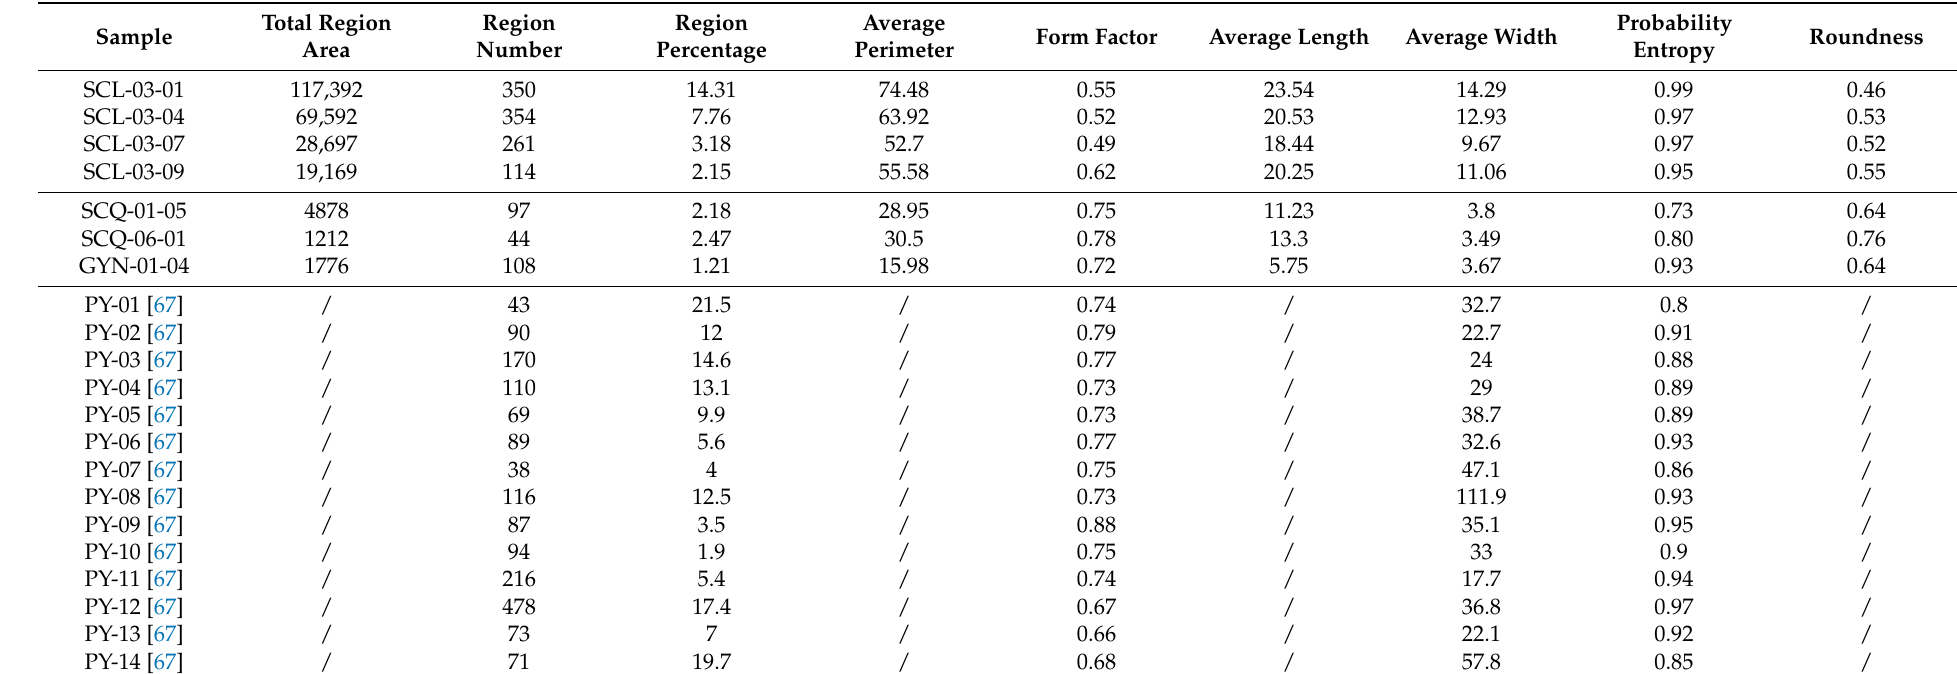
Table 4. Characteristics of OM in the Lower Paleozoic shale from the upper Yangtze